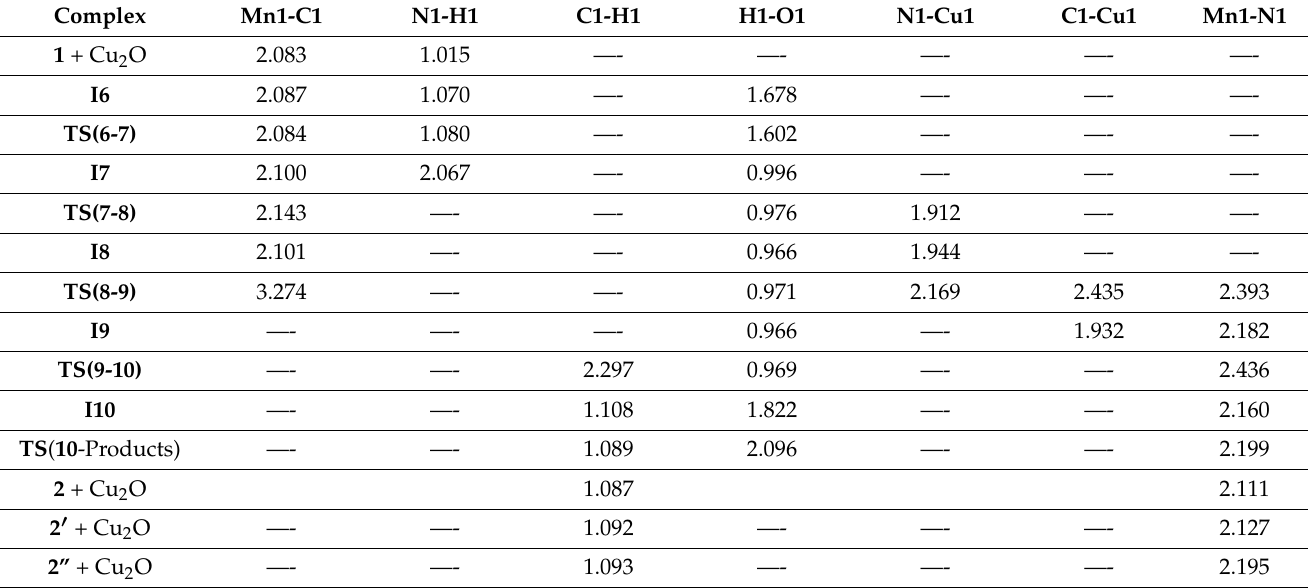
Table 3. Selected bond lengths (Å) of theoretically optimized structures (B3P86/6-31+G(d) level of theory) in mechanism M2 .